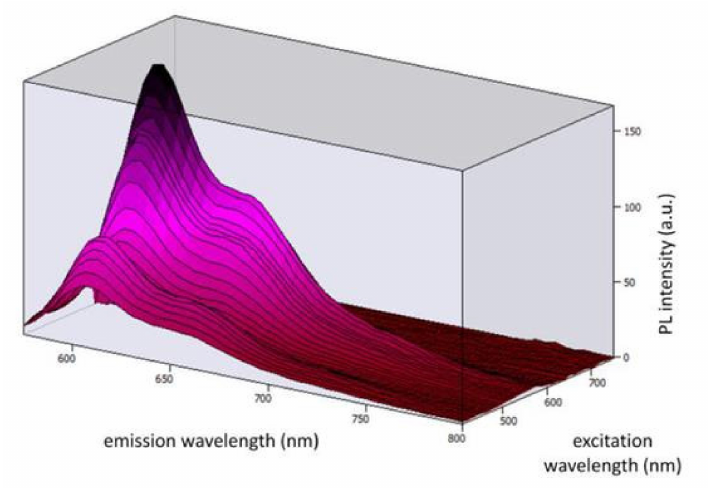
Figure 5. Three-dimensional photoluminescent spectra under the excitation wavelengths from 410 nm to 740